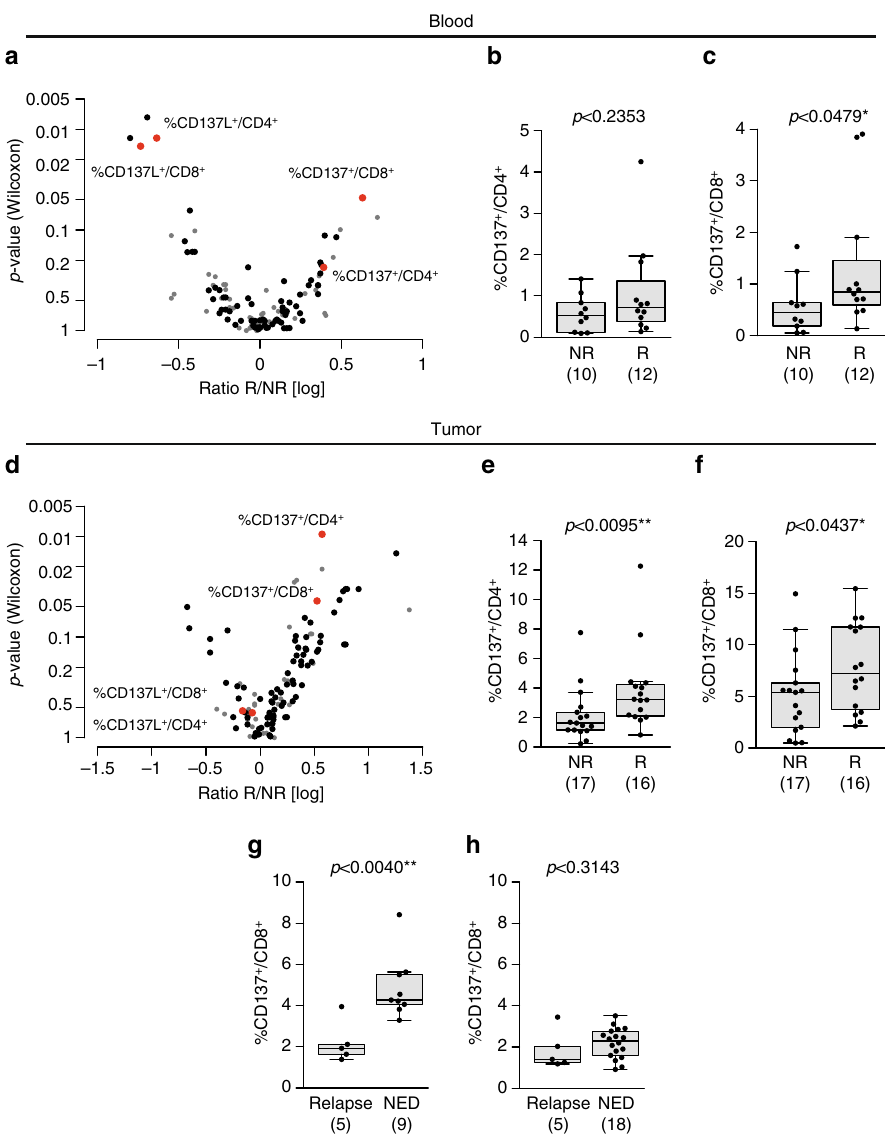
Fig. 7 CD137 expression on blood CD8 + T cells predicts sensitivity to the combination of anti-CTLA-4+ anti-PD-1 Ab. a , d Display of the Wilcoxon rank- sum test p -values vs. the log transformed ratio between responders (R) and non-responders (NR) to anti-CTLA-4 + anti-PD-1 Abs in the blood a and tumor d in the ex vivo mLN assay. Each dot represents one marker; selected biomarkers are shown in red while biomarkers with low level of expression are shown in gray . b − f Expression levels of CD137 in blood b , c and tumor bed e , f of CD4 + b , e and CD8 + T c , f cells, respectively, in patient lesions responding (R) or not (NR) in the ex vivo mLN assay anti-CTLA-4 + anti-PD-1 mAbs stimulatory condition. Each dot represents one patient. The absolute numbers of patients are indicated in both groups in parentheses. Graphs were analyzed by Wilcoxon rank-sum test. g , h Prospective analysis of CD137 expression on T cells prior to enrollment in a Phase II trial of high risk stage IIIc/IV MMel patients. Distributions of CD137 expression on blood CD8 + T cells at diagnosis prior to PD-1/CTLA-4 co-blockade g or PD-1 blockade h across patient groups strati fi ed based on progression (relapse or no evidence of disease [NED]) with a median follow-up of 13 months post enrollment in adjuvant therapy for stage III/IV resected MMel. Each dot represents the fl ow cytometry analysis value of CD137 expression compared with an isotype control mAb prior to adjuvant therapy. Reported p -values are obtained from the Wilcoxon rank-sum test. Box and whisker plots are represented from the corresponding distribution b , c , e −